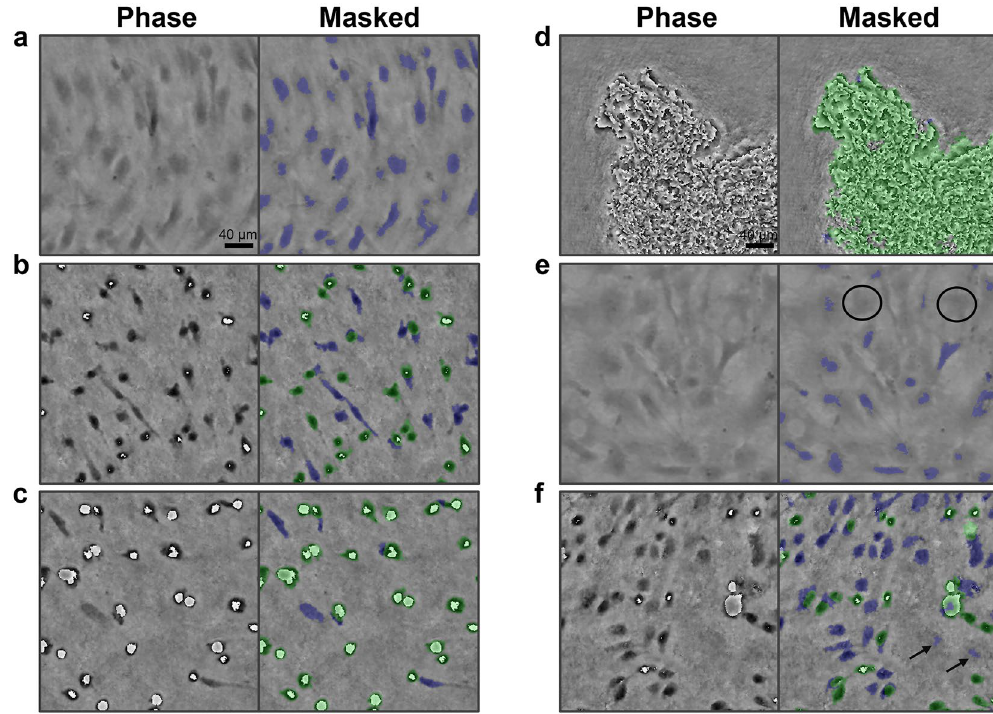
Figure 5. Qualitative validation of the developed algorithm for the detection of attached and detached cell regions. The validation was shown for 6 out of the 35 different datasets, at randomly selected timepoints, with: ( a ) donor 1 (day 7, no dilution, frame 1), ( b ) donor 3 (day 5, no dilution, frame 4), ( c ) donor 7 (day 7, no dilution, frame 55), ( d ) donor 6 (day 7, diluted, frame 10), ( e ) donor 6 (day 5, no dilution, frame 1) and ( f ) donor 5 (day 5, diluted, frame 15). The segmented pixel regions were overlaid on the raw phase image, with attached and detached cell regions displayed in blue and green, respectively. Examples of false negative and false positive regions were indicated by a black circle and arrow,